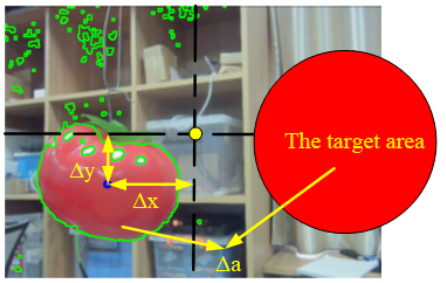
Figure 18. Schematic diagram of the return deviation of the target identification system.